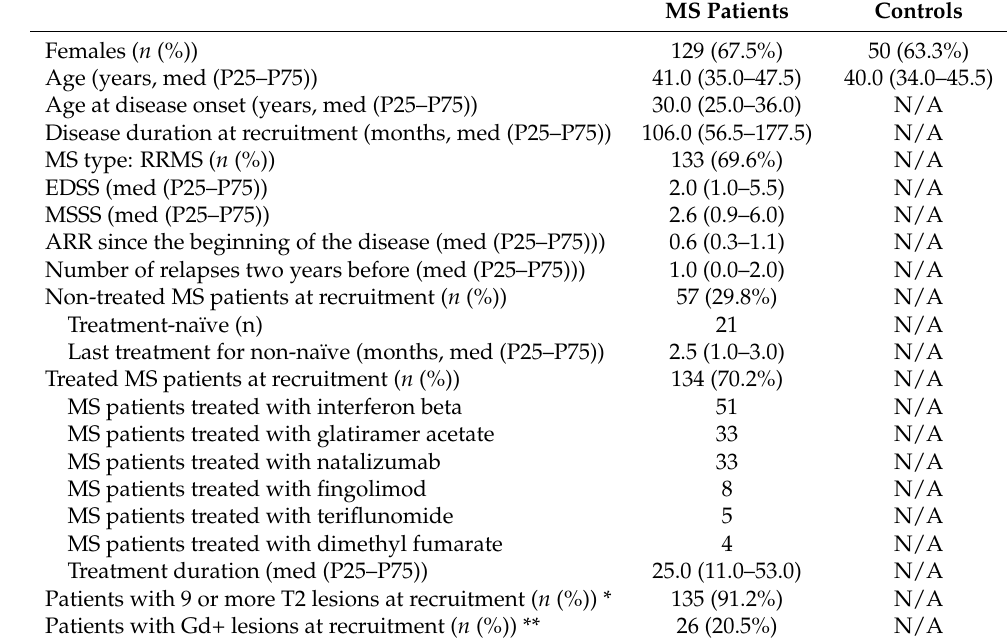
Table 1. Demographical characteristics of the relapsing-remitting multiple sclerosis (RRMS) patients and healthy controls included in the study at the sample